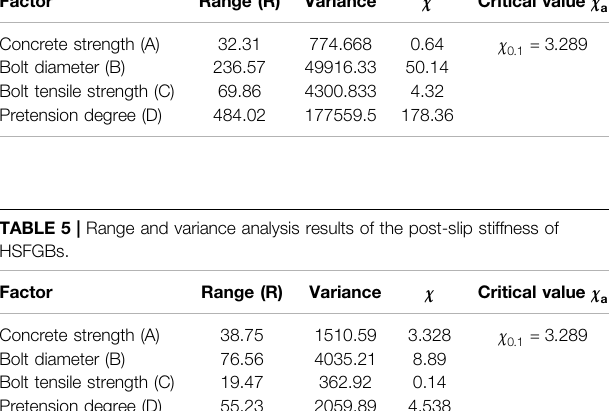
FIGURE 15 | In fl uence of the four factors on the post-slip stiffness of HSFGBs.